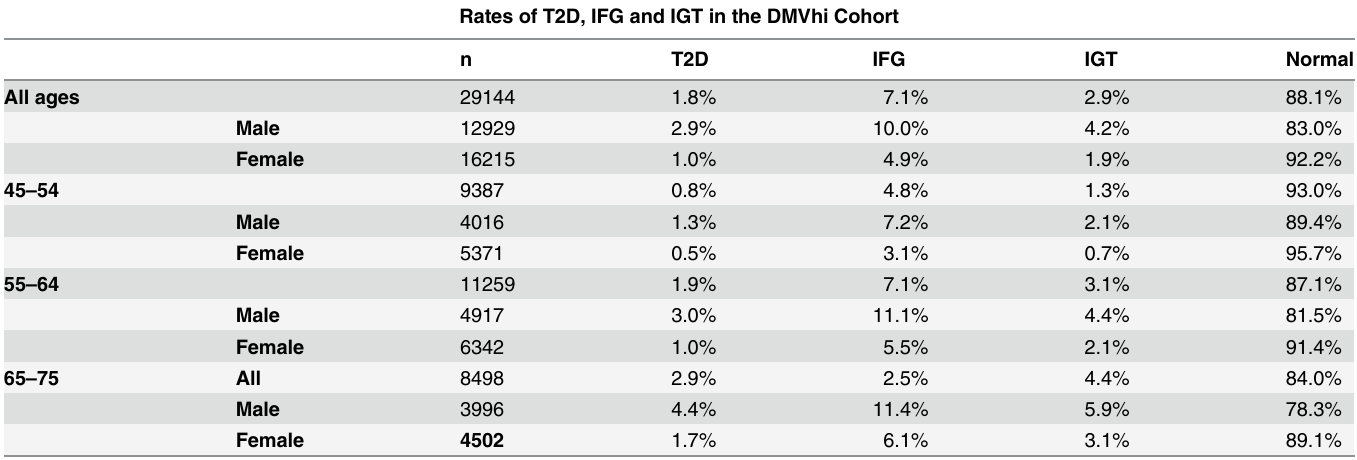
T2D = type 2 diabetes, IGT = impaired glucose tolerance and IFG = impaired fasting glucose. Gender differences for DMVhi cohort and for each age group: p <